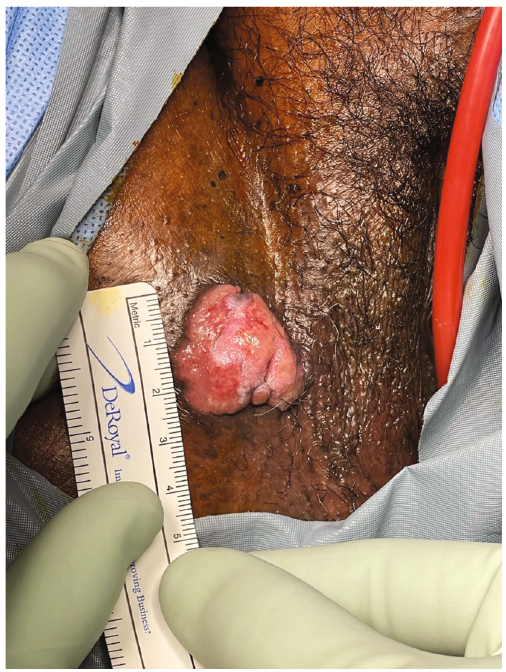
Figure 2: Raised fungating mass within the right inferior vulva measuring approximately 4 cm × 3cm .